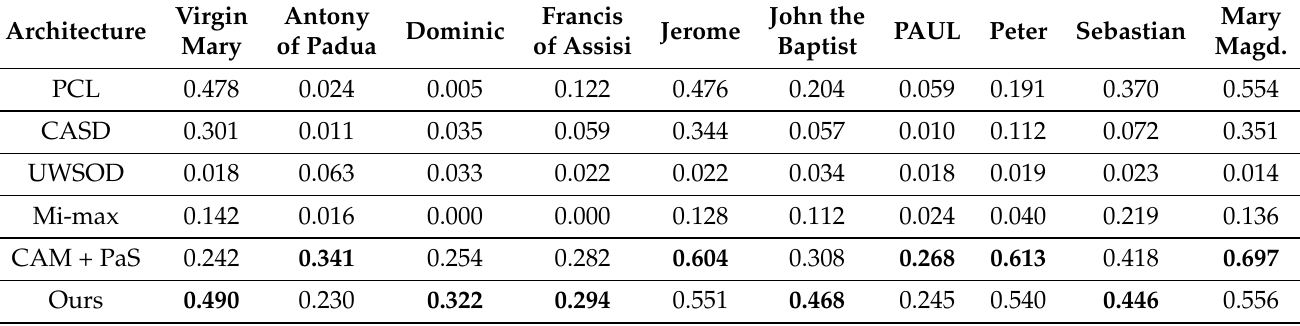
Table 8. Per-class WSOD performance on ArtDL 2.0 —Detection capabilities are evaluated on the ArtDL 2.0 test set for each class using the AP metric. The best-performing architecture for each class is highlighted in